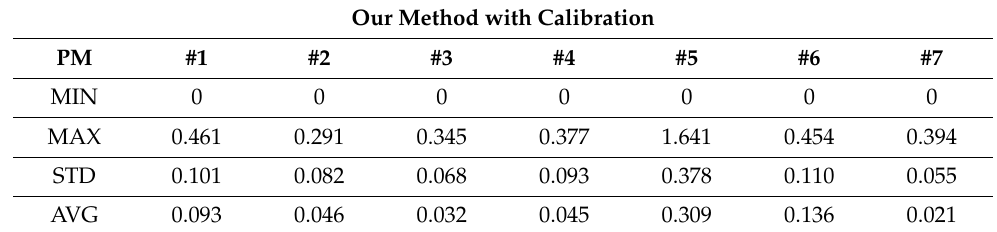
Table 3. Evaluation result of the proposed system in the air.